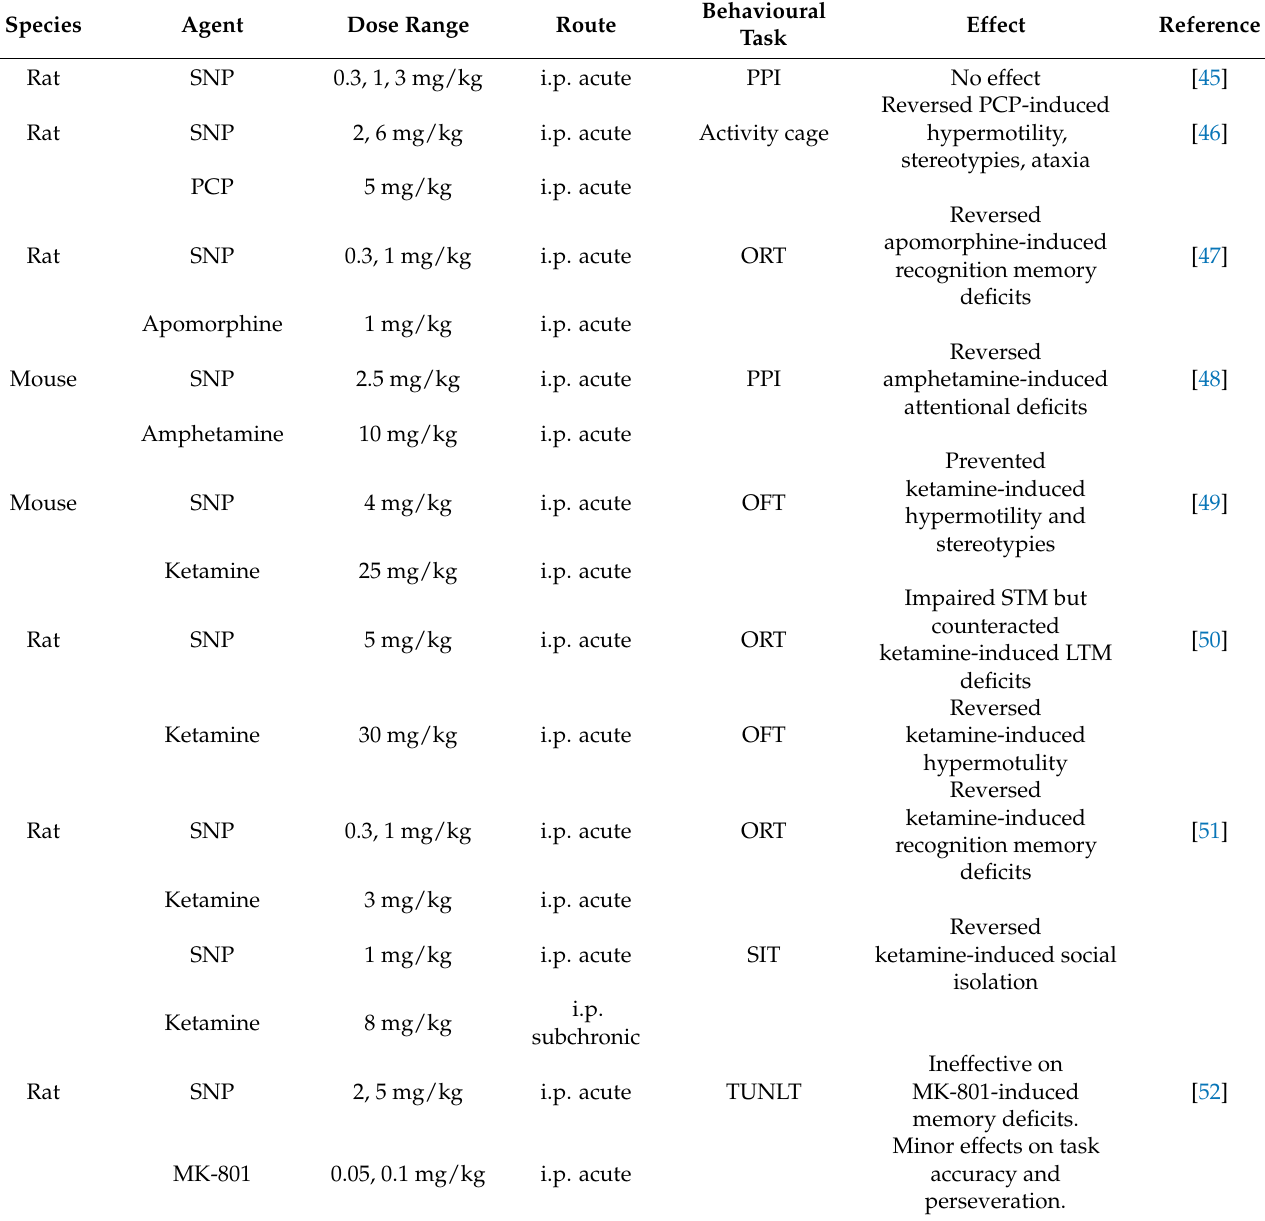
Table 1. Effects of sodium nitroprusside (SNP) on preclinical models of schizophrenia. Species Agent Dose Range